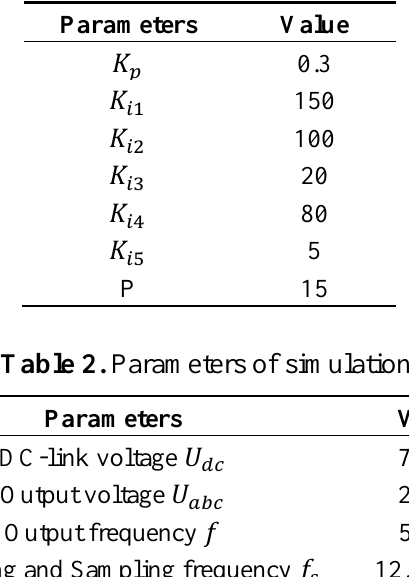
Figure 10. Diagram of root locus with varying parameter 𝐾 maintained constant.